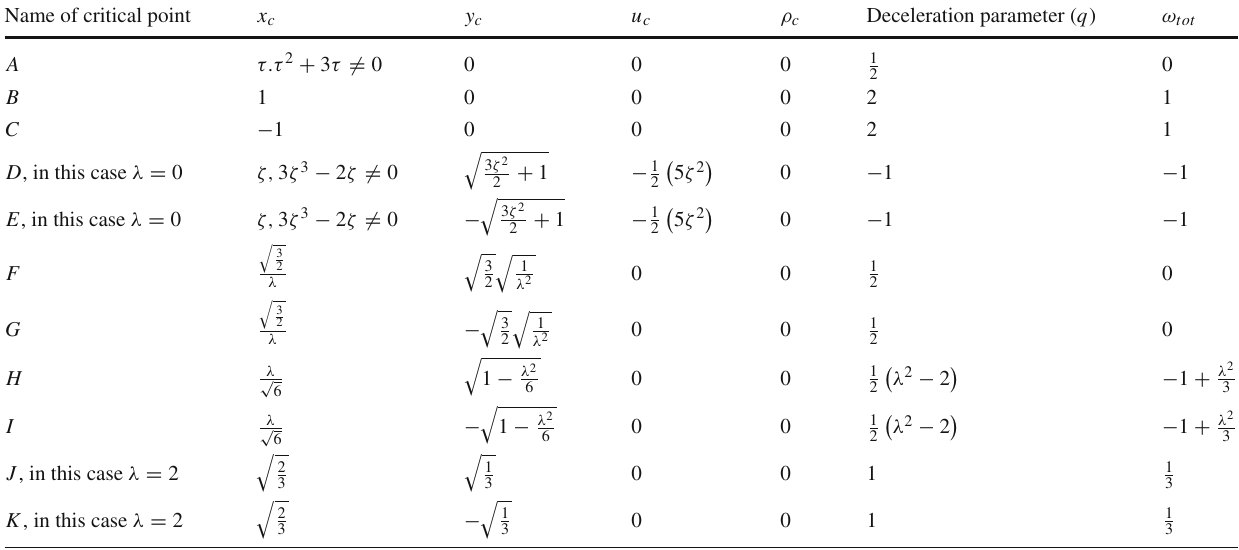
Table 5 Critical points for dynamical system corresponding to Model-I, α = 2 Name of critical point